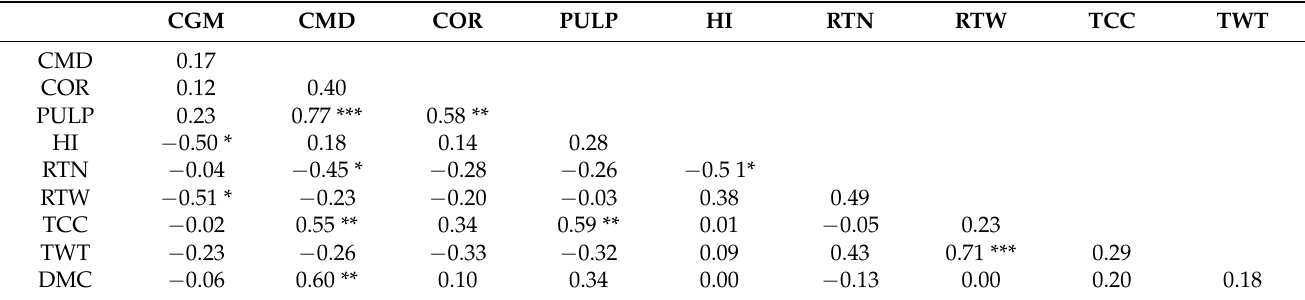
Table 6. Phenotypic correlation of measured cassava characteristics evaluated across two locations.